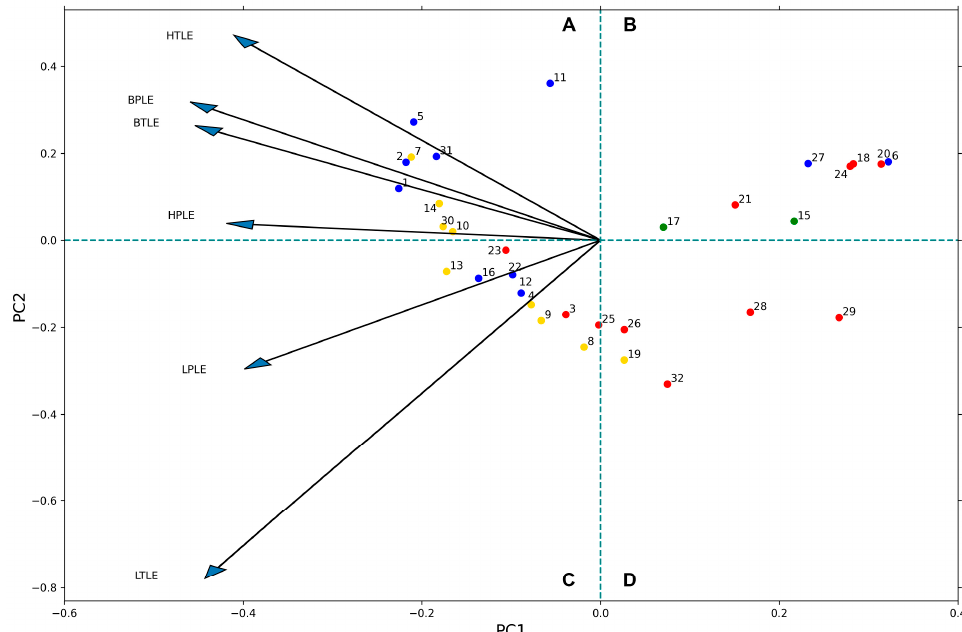
Figure 12. Principal component analysis (PCA) biplot of the permeability data (n = 3). The dots rep- resent compounds and the dots color represent net charge of the compounds at pH 7.4 (blue: positive, red: negative, yellow: neutral, and green: zwitterionic). Arrows represent assays. The compounds are numbered as in Figure 2D.